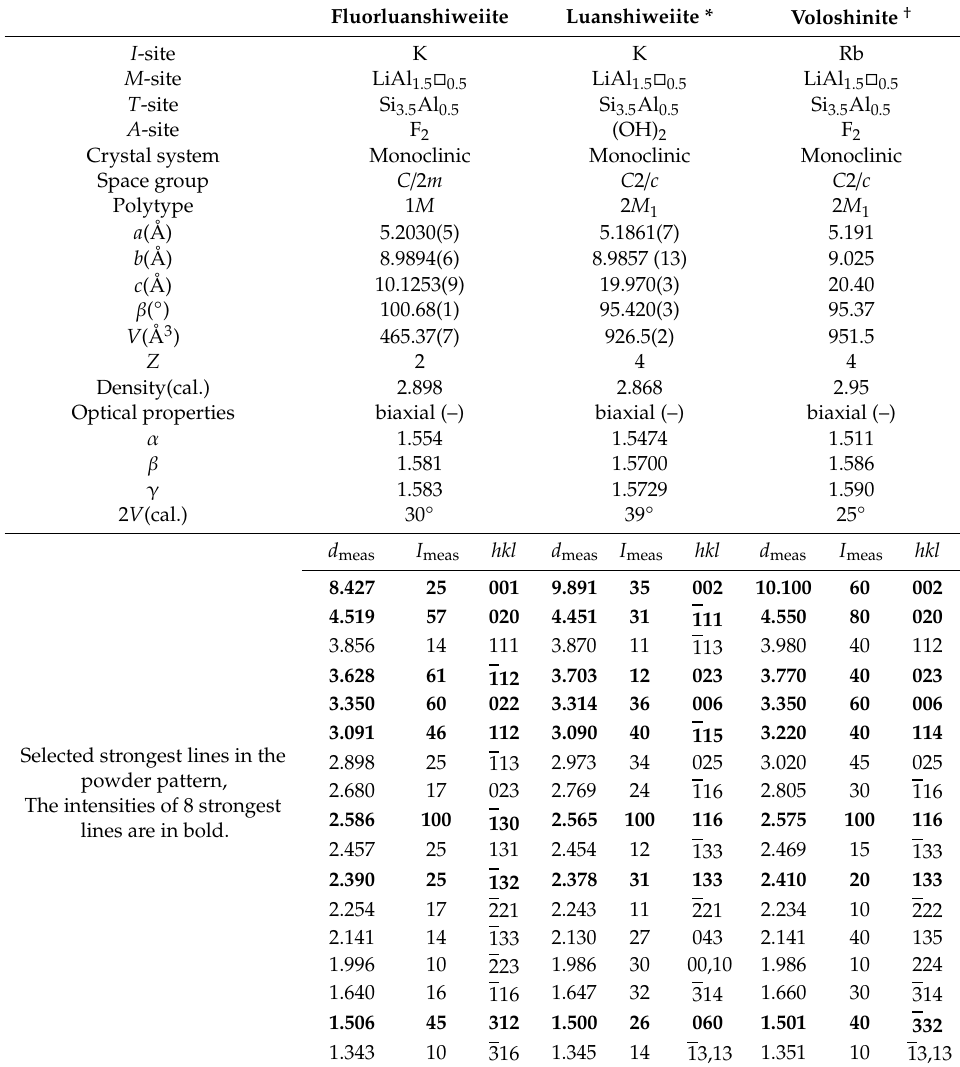
Table 8. Comparative characteristics of fluorluanshiweiite and other minerals of the lepidolite species having a similar